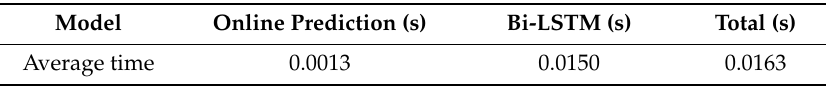
Table 3. Average runtime of the recognition.